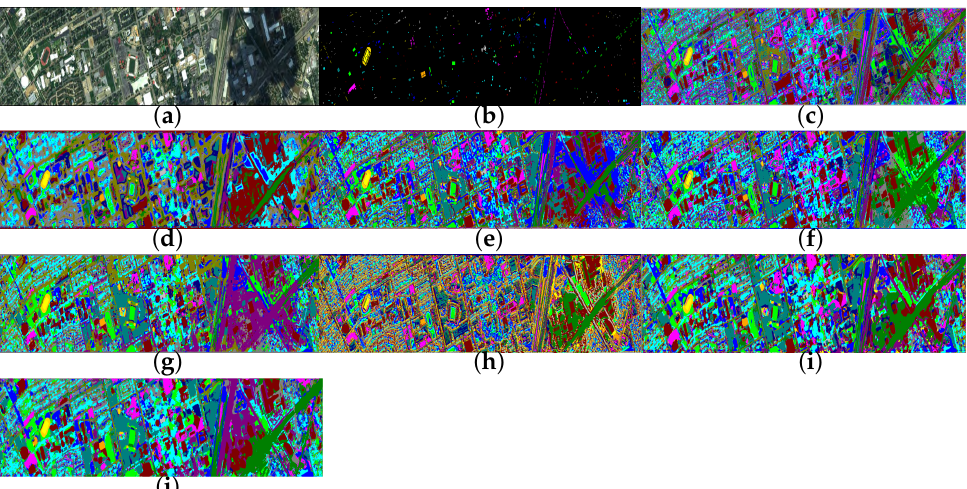
Figure 13. Classification maps for the Houston dataset with 10 labeled training samples per